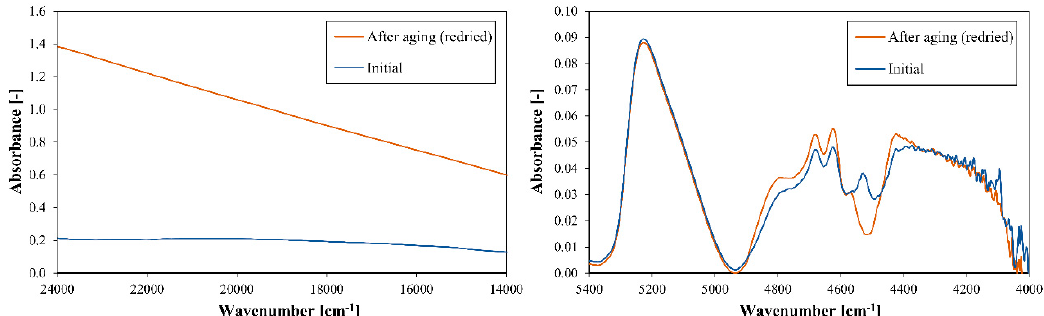
Figure 4. FT-NIR spectra of initial resin and redried epoxy after hygrothermal aging. ( Left ): visible light region. ( Right ): NIR region.